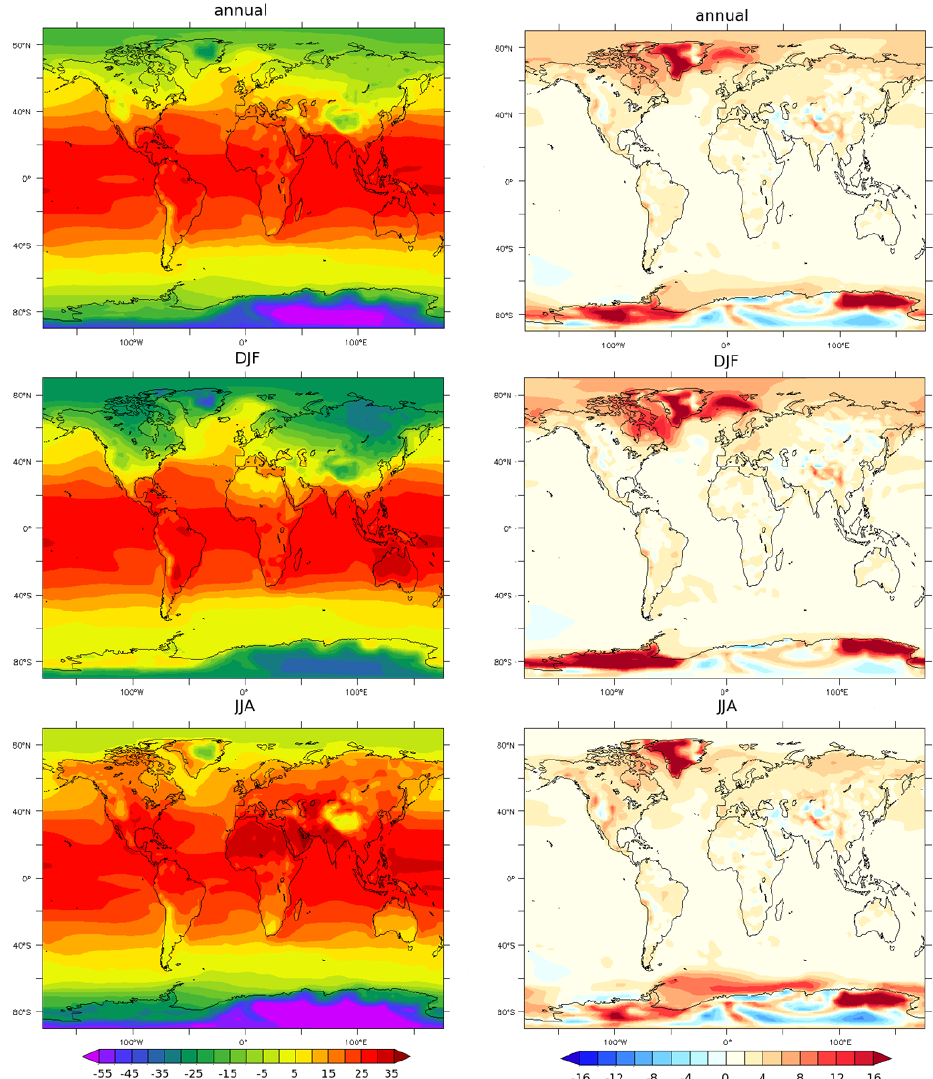
Fig. 9. AOGCM mid-Pliocene mean surface temperatures (left) for yearly average, December-January-February, June-July-August, and their anomaly to the control (right), expressed in degrees Celsius.